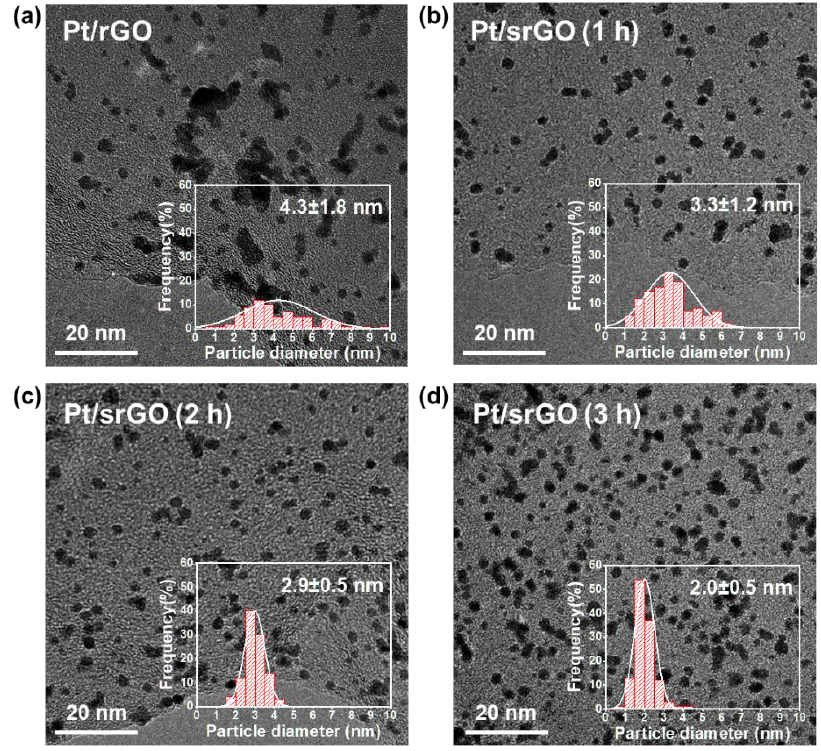
Figure 4. TEM images and corresponding Pt particle size distribution histograms of ( a ) Pt/rGO, ( b ) Pt/srGO (1 h), ( c ) Pt/srGO (2 h), and ( d ) Pt/srGO (3 h).